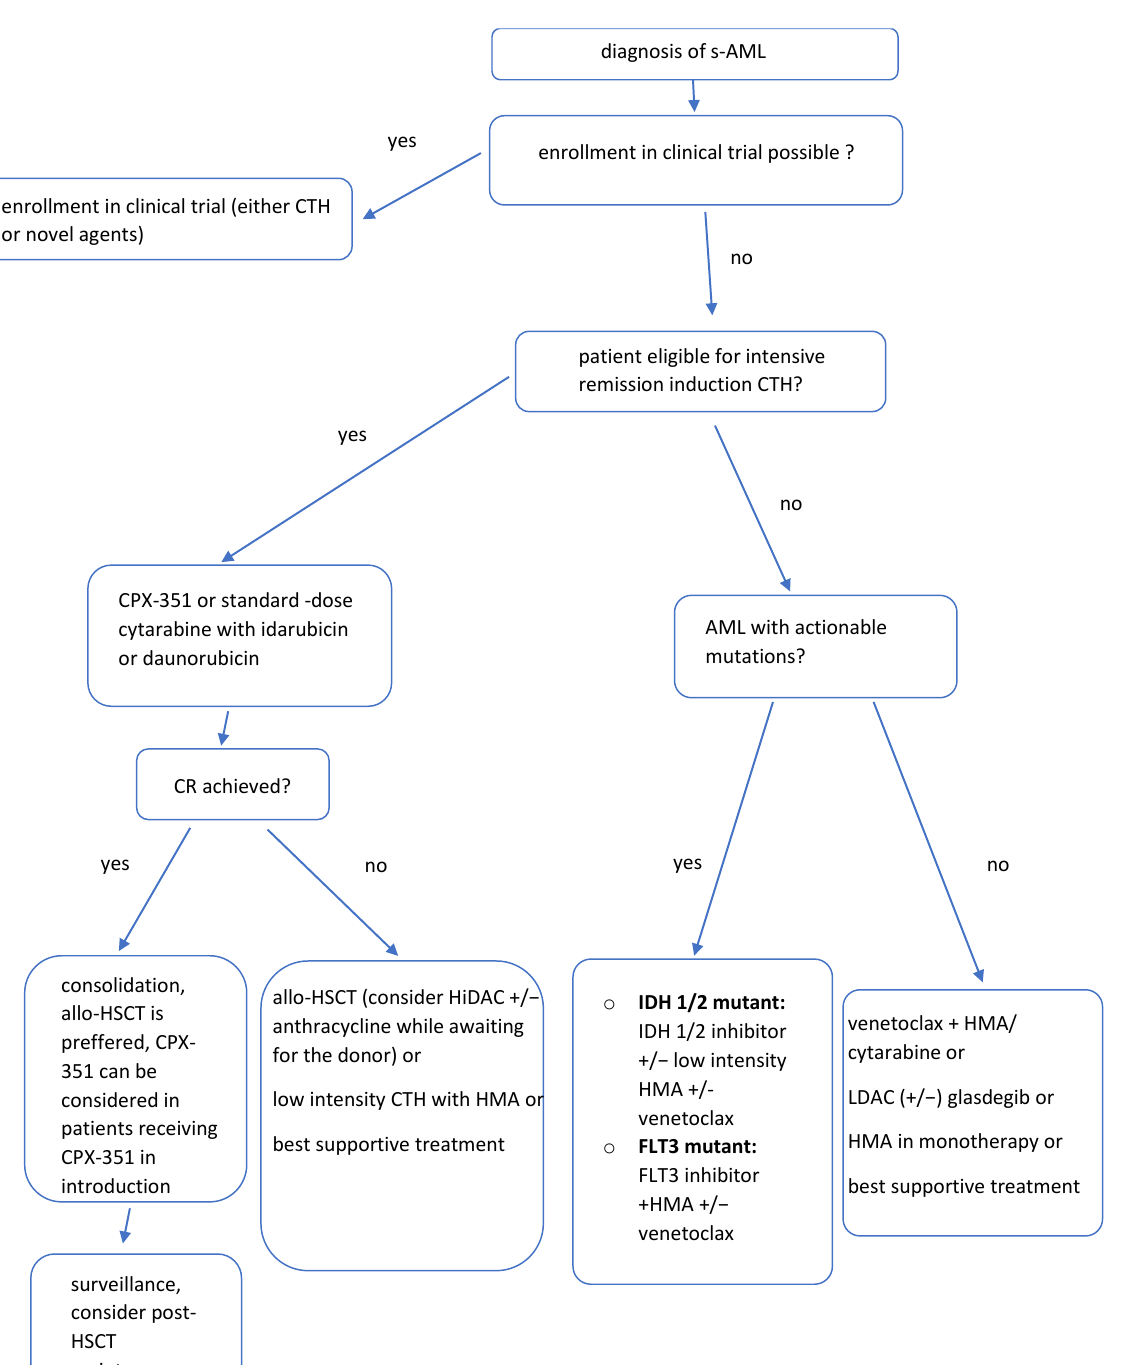
Figure 2. The proposed treatment algorithm in s-AML [110 – 113]. Patients with s-AML generally have poor prognosis, that is why their enrollment in a clinical trial for treatment induction is strongly encouraged. The management depends on a patient’s eligibility for intensive remission induction. Allogeneic HSCT remains the best option for long-term disease control, so HLA testing should be performed promptly in those who may be candidates for either fully ablative or reduced-intensity conditioning. s-AML—secondary acute myeloid leukemia, CTH—chemotherapy, allo-HSCT—allogenic hematopoietic stem cell transplantation, HiDAC—high dose intermittent cytarabine, HMA—hypomethylating agents, LDAC—low-dose